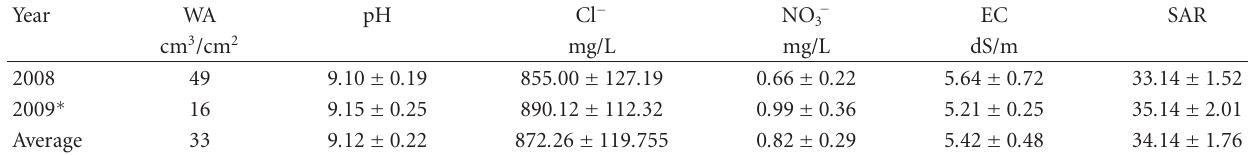
Table 2: Chemical properties of the wastewater in the study site during 2008 to